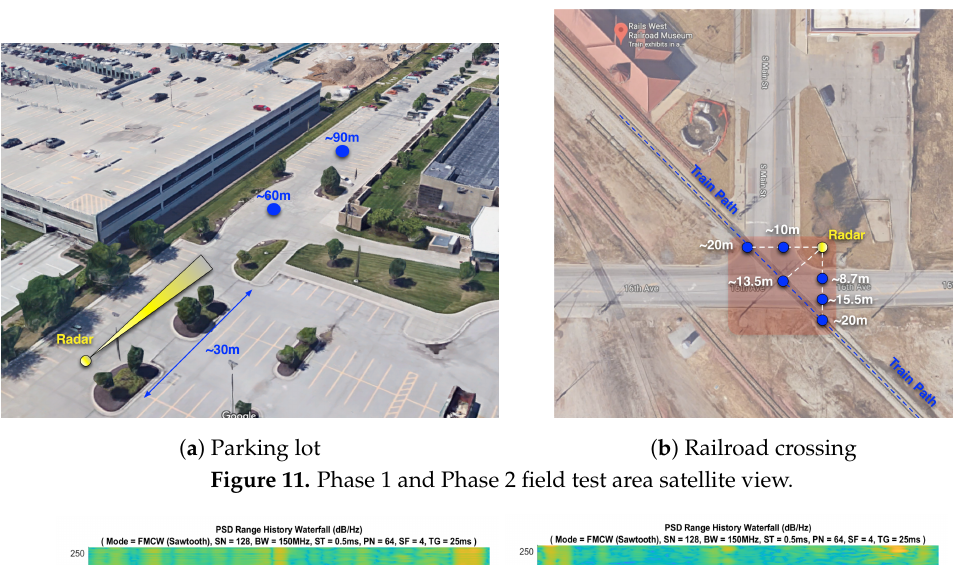
Figure 10. Signal processing steps.